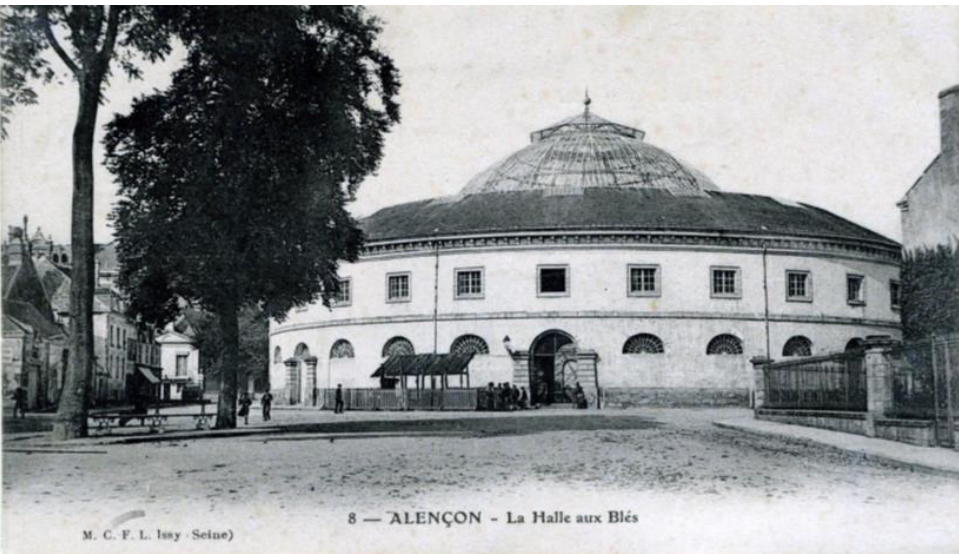
Figure 8. La Halle aux Blés. Photograph showing the replacement of the old wooden structure of the dome with iron and copper ribs according to the design of Bellangé and Brunet in Paris 1811 – 1820 by Bellangé. Source: Extract from Dictionnaire des rues et monuments d ’ Alençon (Alain Champion, Éditions Cénomane, 2003).